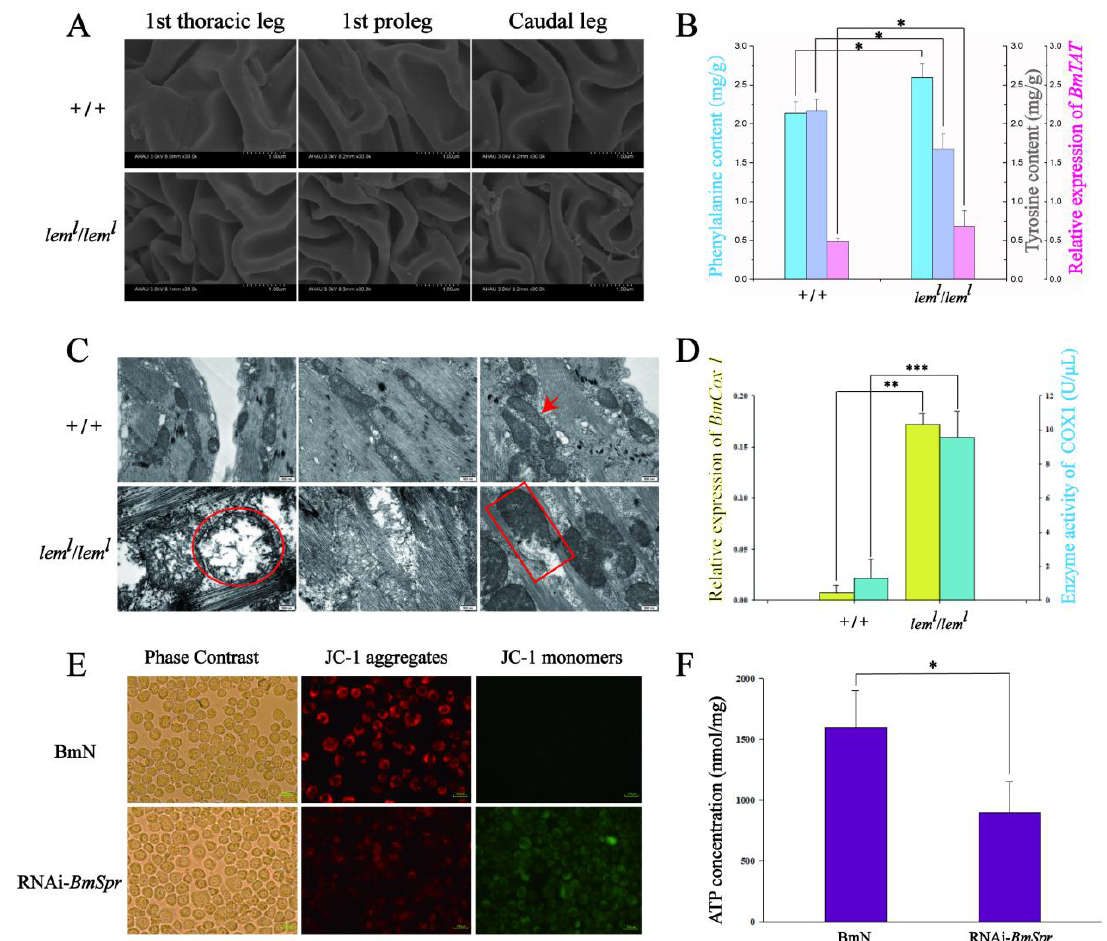
Figure 2. Abnormal amino acid metabolism in lem l homozygotes led to mitochondrial damage. ( A ) Scanning electron microscope of lem l epidermis at 30,000 × magnification. ( B ) The content of tyrosine (represented by blue columns) decreased, the content of phenylalanine (represented by purple columns) and the expression of BmTAT (represented by pink columns) increased in lem l . ( C ) Transmission electron microscopy of mitochondria in the head of lem l . The three panels under the same strain represent three different perspectives. The red arrow represents normal mitochondrial morphology, the red circle represents obvious vacuoles in swollen mitochondria, and the red rectangle represents rupture of swollen mitochondrial membrane and outflow of mitochondrial matrix. The scale bar in the lower right corner represents 500 nm. ( D ) The gene expression level (represented by yellow columns) and enzyme activity (represented by blue columns) of COX1 increased in lem l . Mitochondrial membrane potential ( E ) and ATP content ( F ) decreased after RNAi- BmSpr in BmN cells. The scale bar in the lower right corner represents 200 µ m. JC-1 is an ideal fluorescent probe